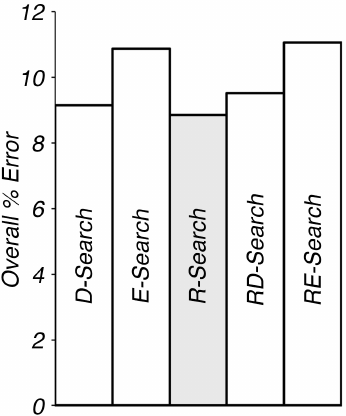
Figure 9. Percentage error of all proposed search algorithms. R-Search is better among all other searches. The authors do believe that this spatial approach for E-GTSP to TSP transformation could be improved by further incorporating heuristic concepts, which is beyond the scope of the current